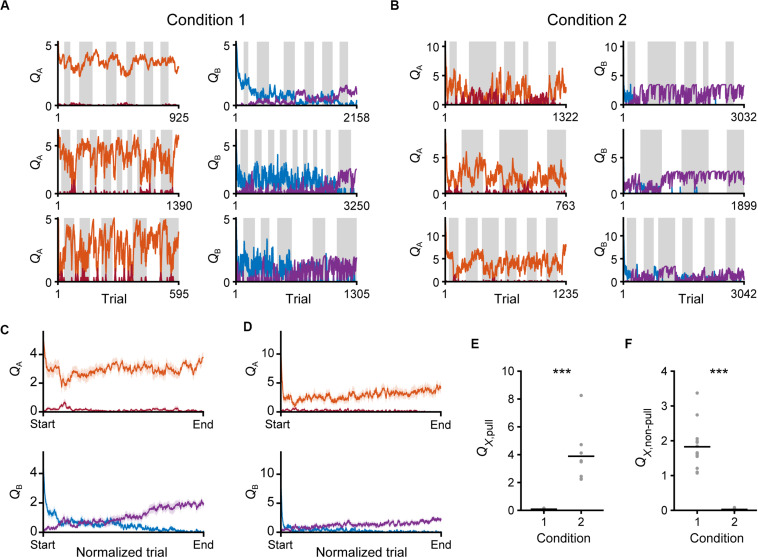
Time courses of Q-values in the saving-F model. (A,B) Six representative time courses of QA, pull (red) and QA, non–pull (red-purple) (left), and QB, pull (blue) and QB, non–pull (purple) (right), in conditions 1 (A) and 2 (B). (C,D) The mouse-averaged time courses of QA, pull (red), QA, non–pull (red-purple) (top row), QB, pull (blue) and QB, non–pull (purple) (middle row) in conditions 1 (C) and 2 (D). The total trial number was normalized across animals. Shading indicates ± SEM. (E) Pull values in tone X trials in the last session. X is B in condition 1 and A in condition 2. ***p = 1.92 × 10–4. (F) Non-pull values in tone X trials in the last session. X is B in condition 1 and A in condition 2. ***p = 1.92 × 10–4. Gray dots represent individual mice, and black bars represent the mean.